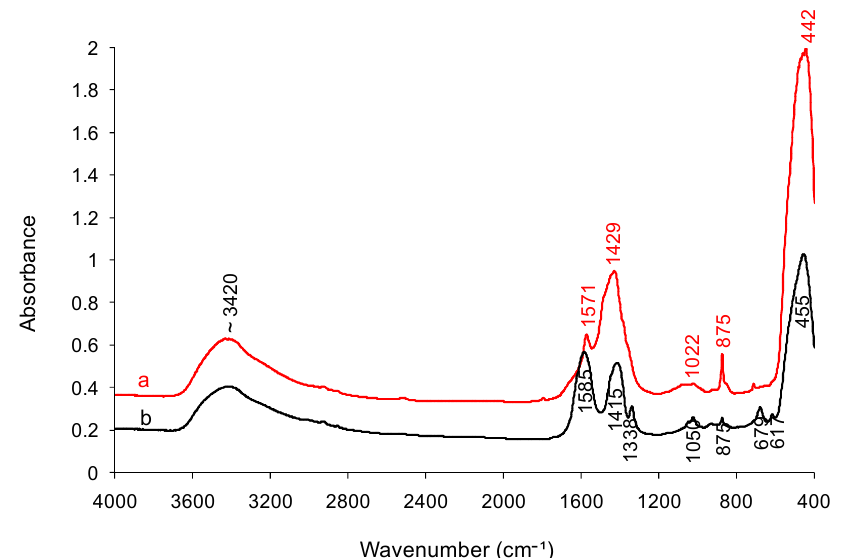
Figure 5. FTIR spectra of ZnO NPs obtained without PyQAs1 ( a ) and with 5% PyQAs1 ( b ).